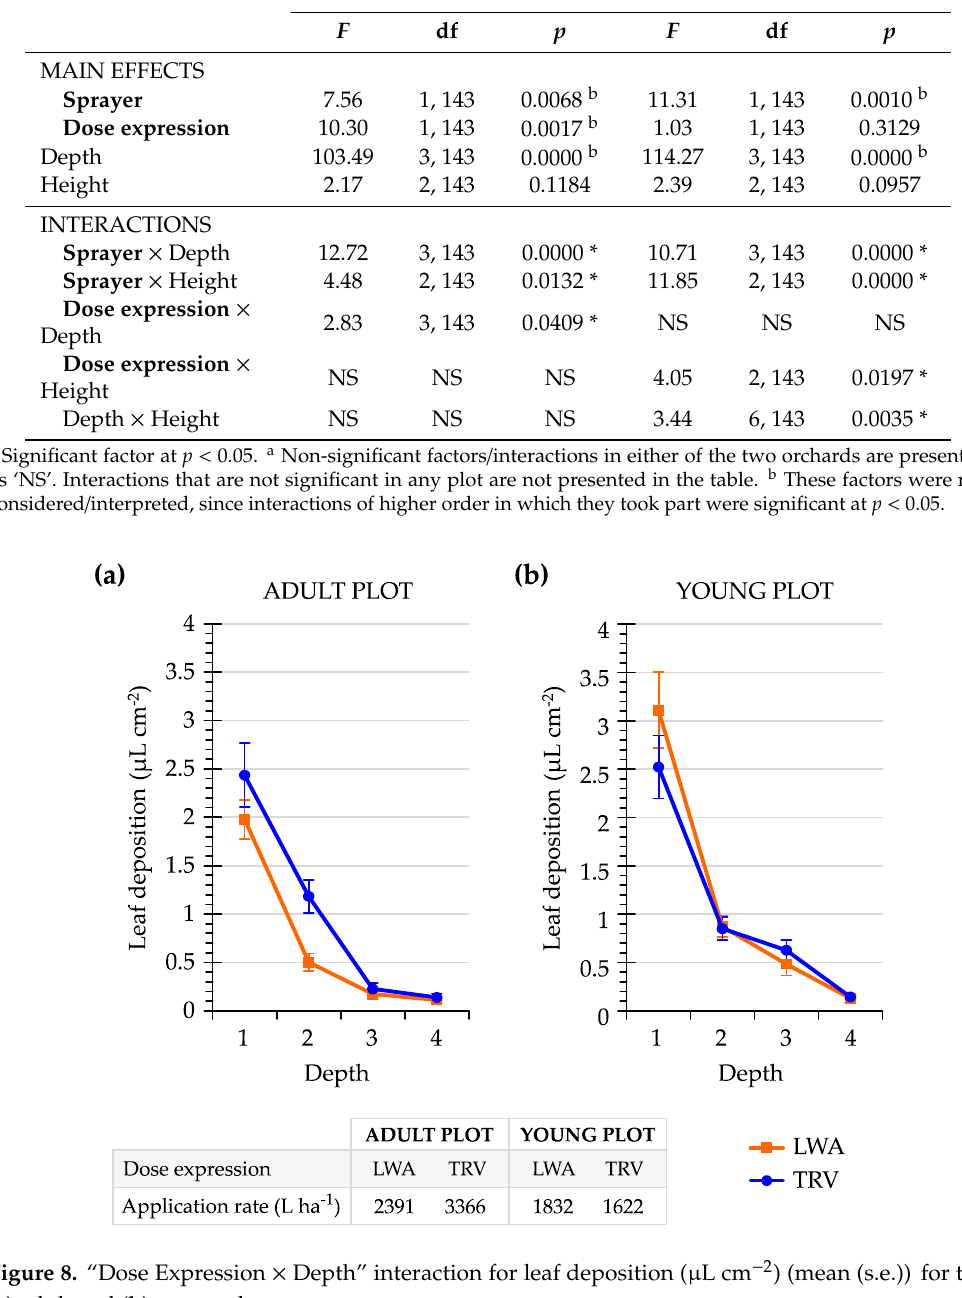
Table 8. Multifactor ANOVA results for the leaf deposition ( µ L cm − 2 ) in the adult and young plots. The main study factors have been highlighted in bold (LSD test, p < 0.05) a . ADULT PLOT